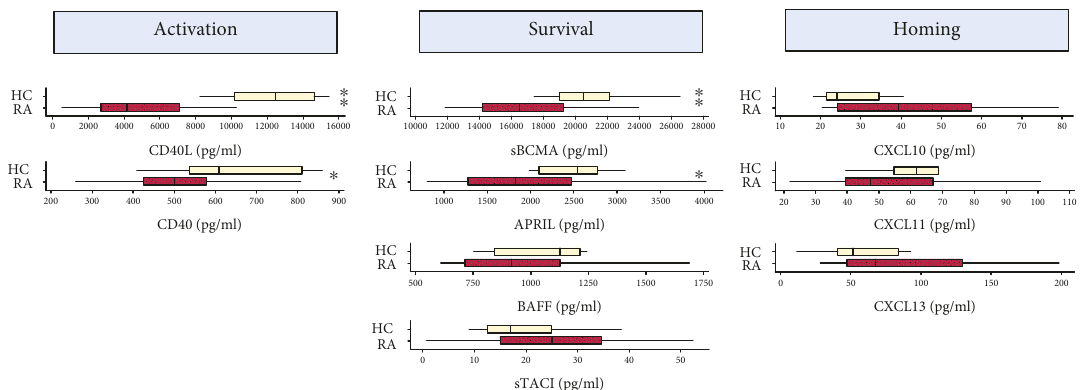
Figure 2: Box plots comparing serum B-cell factor protein levels in RA patients and healthy controls. Levels of each protein are indicated for healthy controls (HC, top yellow box; n = 10 ) and RA patients (RA, bottom red box; n = 23 ). The median value is indicated with a vertical line, with the box comprising the IQR, and whiskers representing the maximum and minimum values within the fences ( ± 1.5 IQR). ∗∗ p < 0 01 and ∗ p < 0 05 . Serum levels of B-cell activation factors (CD40, CD40L) and B-cell/ASC survival elements (sBCMA, APRIL) were signi fi cantly decreased in RA patients compared with healthy